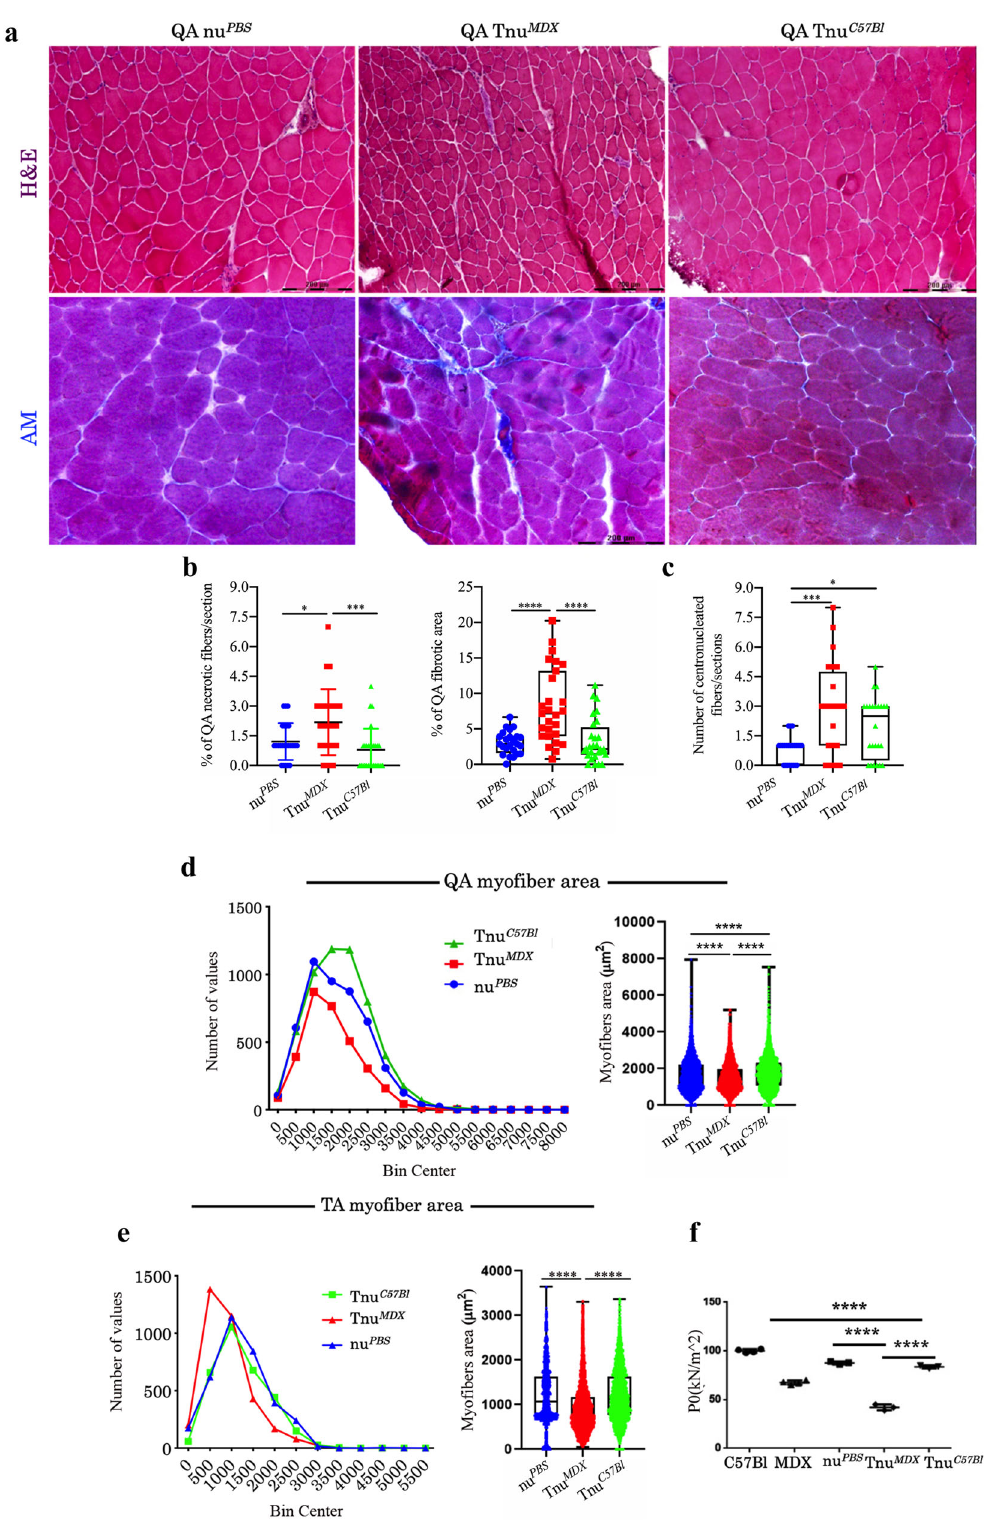
myo fi ber area reduction consequent to loss of sarcomeric protein (nu PBS : 760340.6; Tnu MDX : 621440.8; Tnu C57Bl 785544.3). Furthermore, the values of frequency distribution con fi rmed the smaller area of myo fi bers in Tnu MDX mice (25%